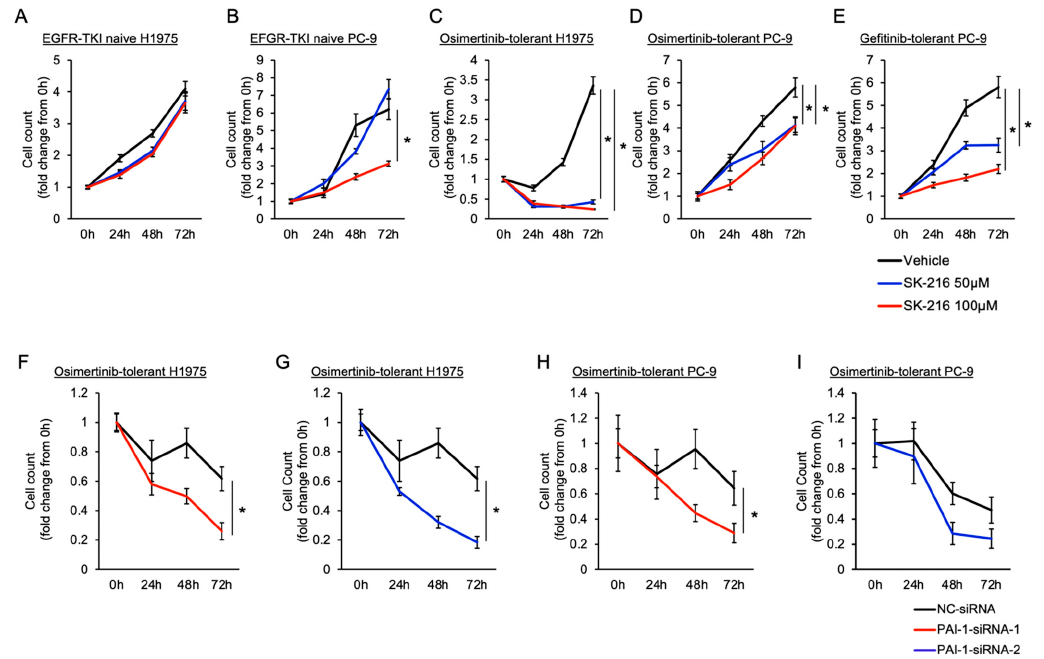
Figure 2. The effect of PAI-1 inhibition on the proliferation of EGFR-TKI-tolerant cells. The fold changes in the EGFR-TKI-naive ( A ) H1975 and ( B ) PC-9 cells between pretreatment and after treat- ment with 0, 50, or 100 µ M SK-216, a PAI-1 inhibitor. The fold changes in ( C ) H1975 and ( D , E ) PC-9 cells with tolerance to gefitinib or osimertinib before and after PAI-1 inhibition. The black, blue, and red lines represent the changes observed after treatment with 0, 50, and 100 µ M SK-216, respectively. The mean fold changes relative to the starting point (0 h) are shown with standard error bars (n = 6). At 72 h, the mean fold changes between the 0 µ M and 50 or 100 µ M treatment regimens were statistically compared; * p < 0.05 compared with cells exposed to vehicle controls (one-way ANOVA with Tukey’s test). ( F–I ) Fold changes in ( F , G ) H1975 and ( H , I ) PC-9 cells with tolerance to osimertinib over time after exposure to siRNAs (PAI-1-siRNA (PAI-1-siRNA-1 and PAI-1-siRNA-2) or negative control siRNA (NC-siRNA)). The data for PAI-1-siRNA-1 and PAI-1-siRNA-2 are shown for the two siRNA reagents described in the Materials and Methods section, s10013 and s10014, respectively. The black, red, and blue lines represent the changes observed after exposure to siRNA, respectively. The mean fold changes relative to the starting point (0 h) are shown with standard error bars (n = 5). At 72 h, the mean fold changes between the PAI-1-siRNA and NC-siRNA exposures were statistically compared; * p < 0.05 compared with cells exposed to NC-siRNA (Student’s t